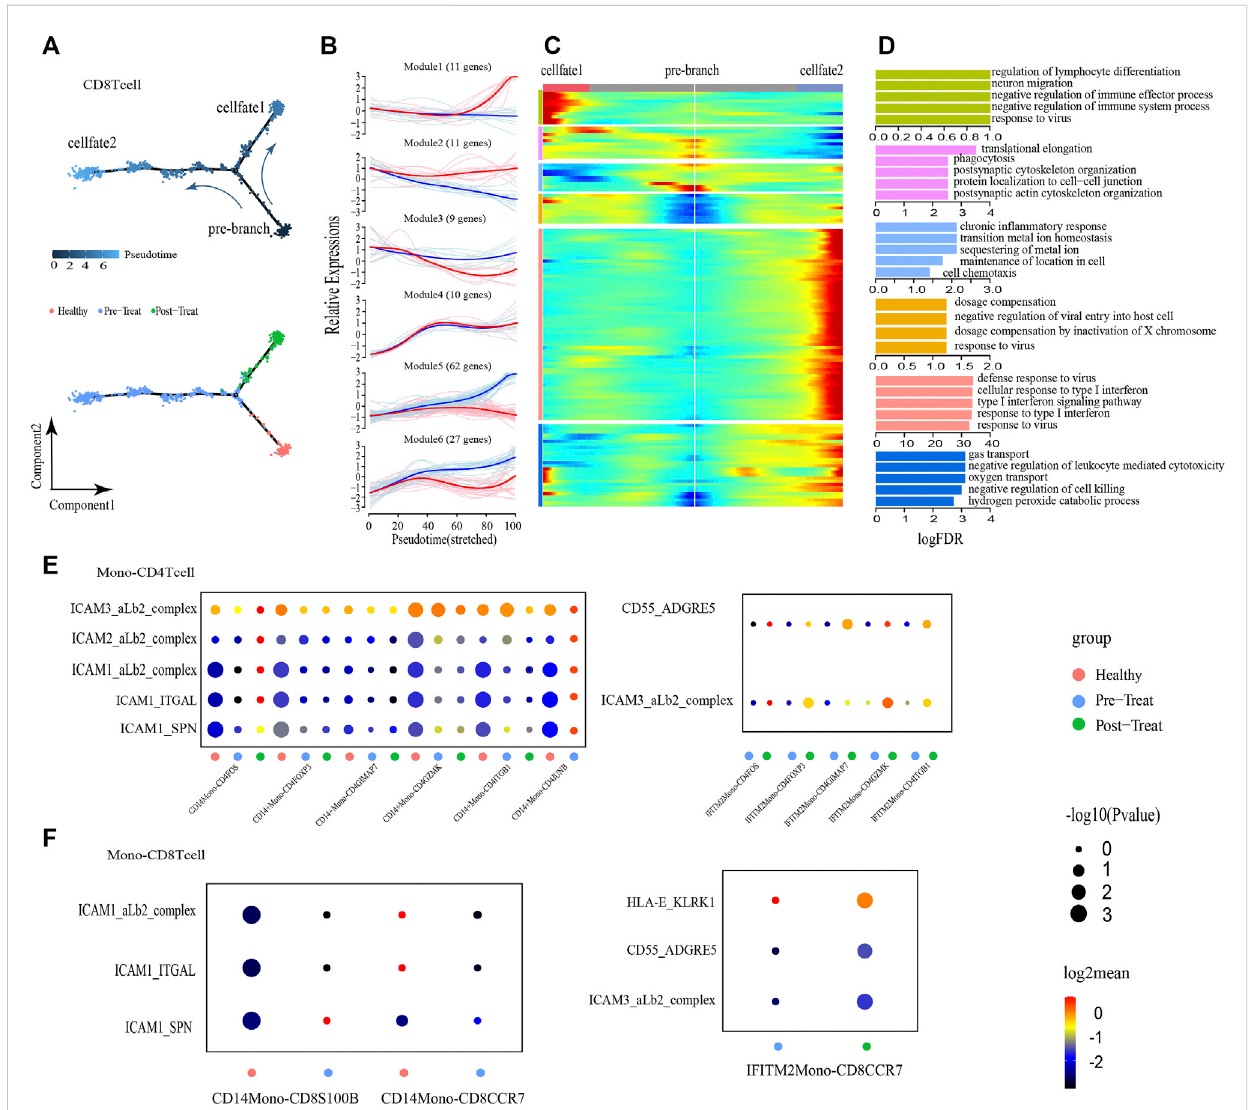
FIGURE 5 CD8 + T cells showed transition from a naive state to an in fl ammatory state and regulated by non-classical monocytes. (A) Pseudotime trajectory (Monocle analysis) of the CD8 + T cell sub-clusters. Cells are colored based according to the predicted pseudotime (up) and groups (bottom). (B)